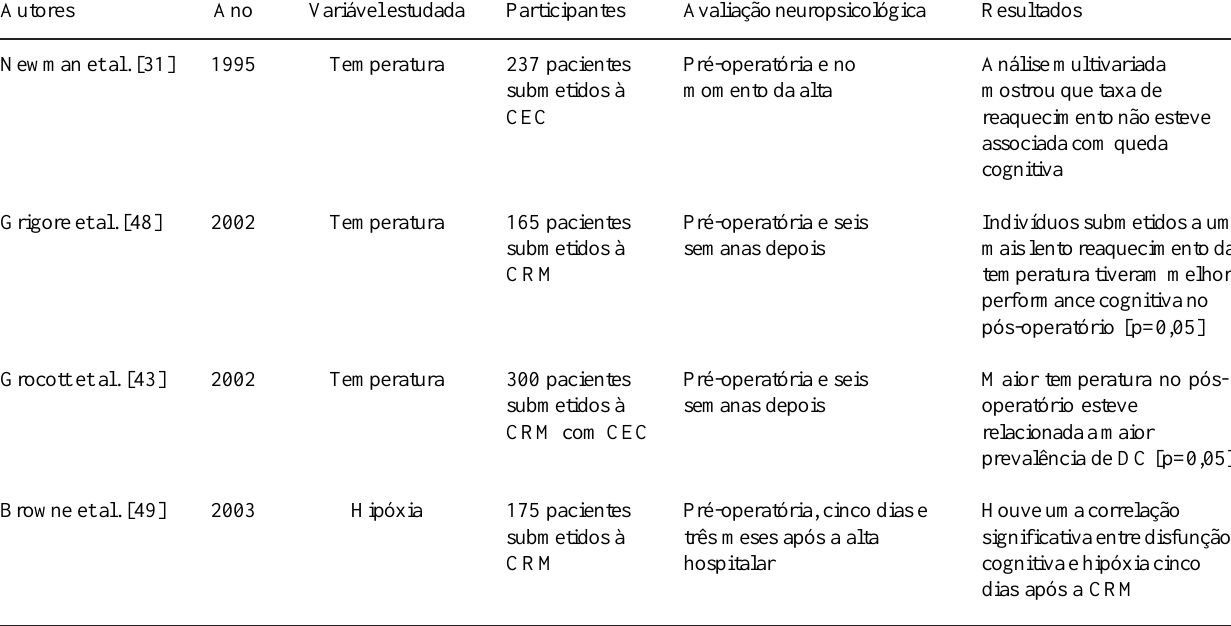
Tabela 3. Fatores pós-operatórios